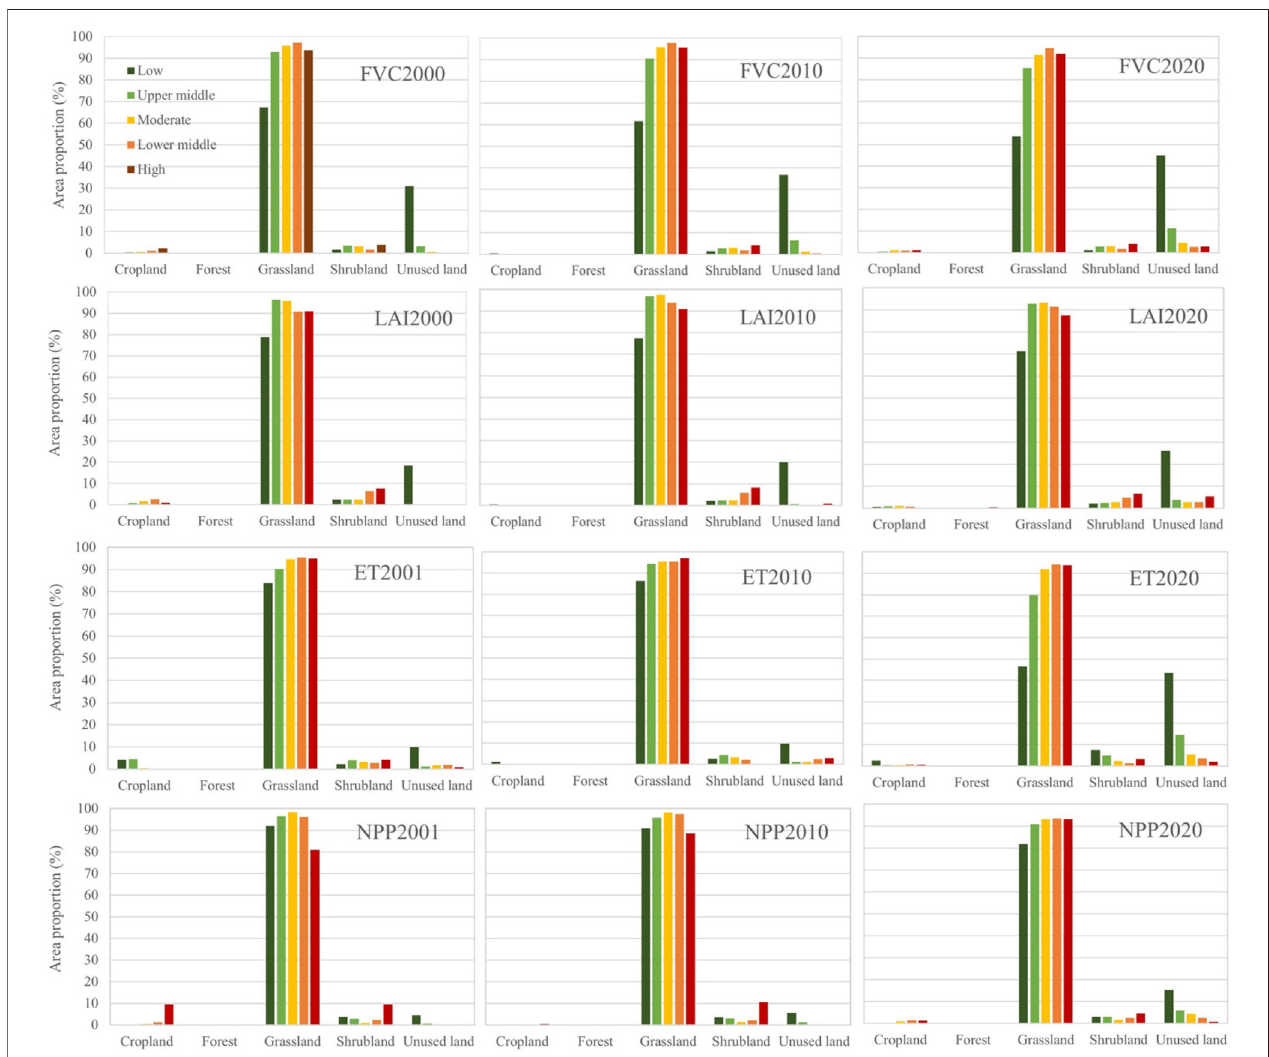
FIGURE 6 | In fl uence of land-use types on multiple ecosystem service indicators during 2000 – 2020.